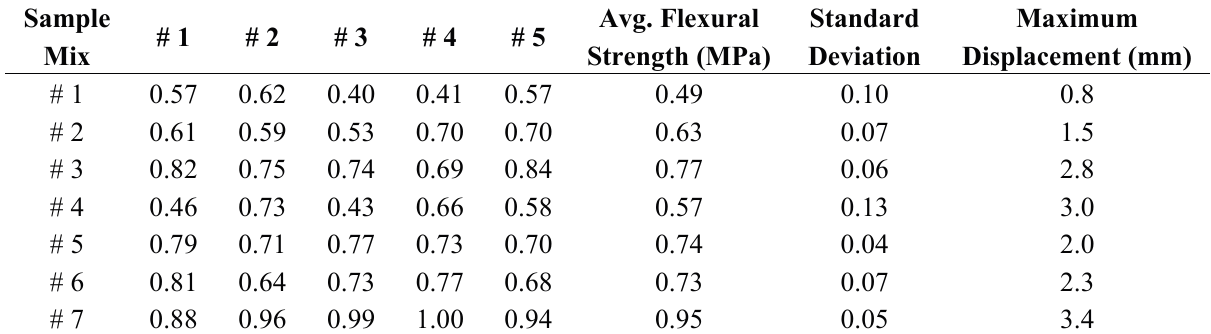
Figure 8. ( a ) Plain CEB flexural failure; ( b ) Reinforced GCEB flexural failure. Table 6. Average flexural strength and maximum mid-span displacement results of GCEBs.